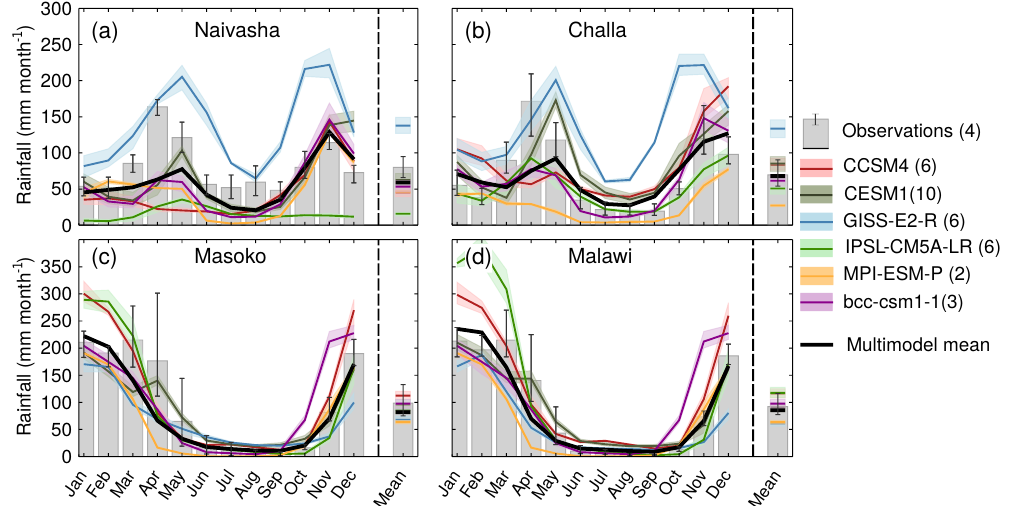
Figure 2. Mean monthly rainfall over lakes Naivasha, Challa, Masoko and Malawi (a–d) in observations (bar plots) and in six CMIP5 models (curves) over the period 1979–2005. The number of data sets (for the observations) or ensemble members (for the models) used in each case is shown in brackets. Error bars and shaded areas represent the range of those observations or ensemble member values.